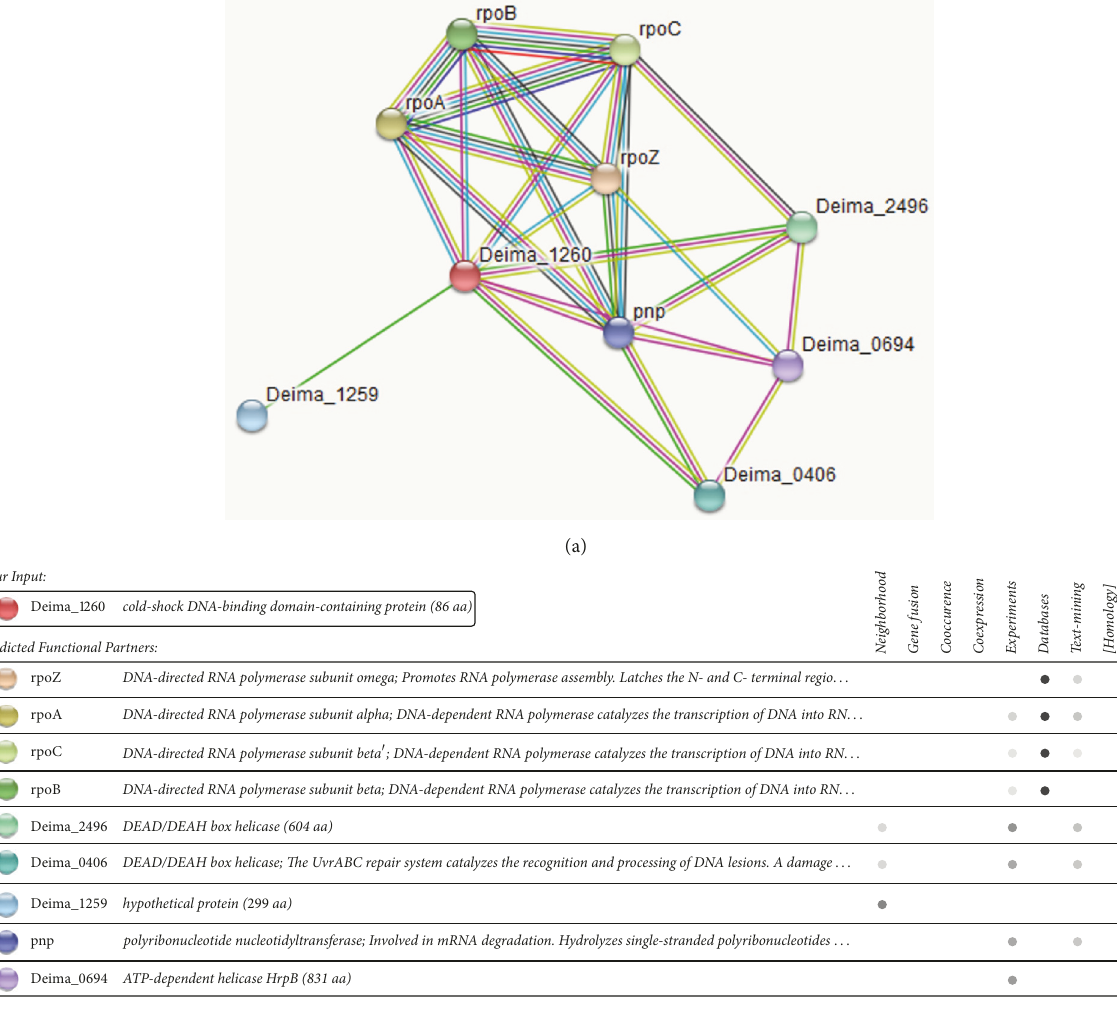
Figure 7: STRING protein-protein interactions of Dm-Csp1 . STRING network map (a) and summary table of predicted interactions (b). The category of interaction is shown in the table. Color saturation of the edges represents the confidence score of a given functional or physical association. The position of Dm-Csp1 is labeled Deima 1260. Shown interactions are considered of high confidence when yielding scores of greater than